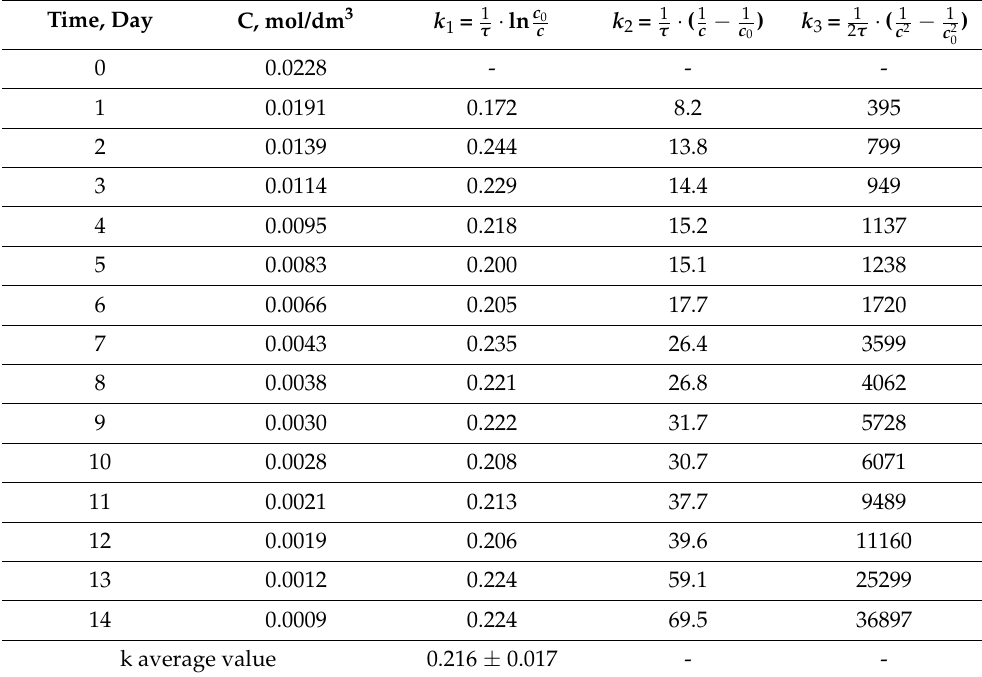
Table 2. Experimental data and calculation of the rate constant of the biological decomposition of CAPB by the strain Pseudomonas pseudoalcaligenes (B-6783) VSB-10. Time,